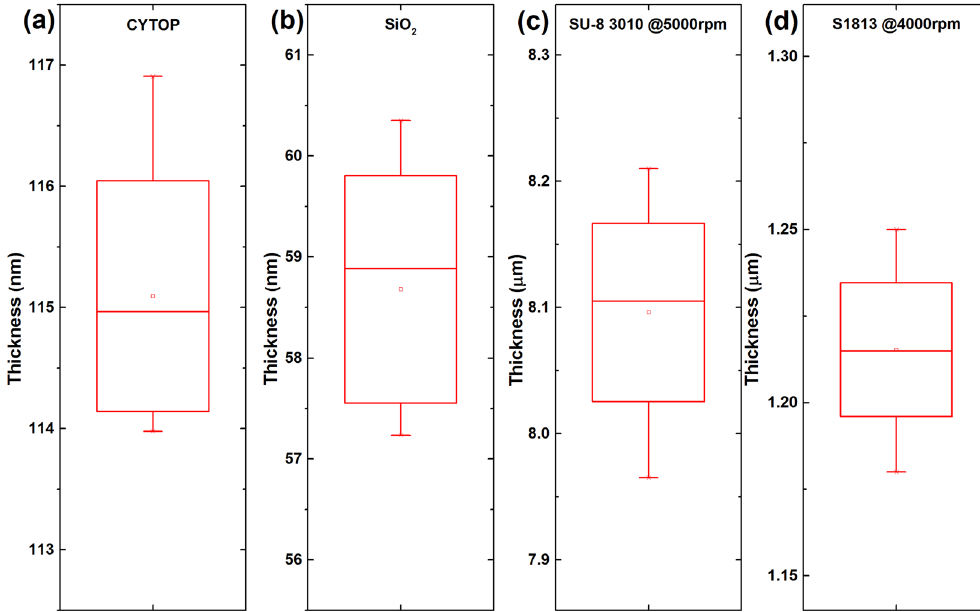
Figure3. Film thickness measurement around the 4-inch substrate of ( a ) CYTOP, ( b ) SiO 2 on CYTOP, and the coated high ( c ) and ( d ) low viscous photoresists. The thickness fluctuations of these films are less than ± 3% with 3 mm edge exclusion zone.